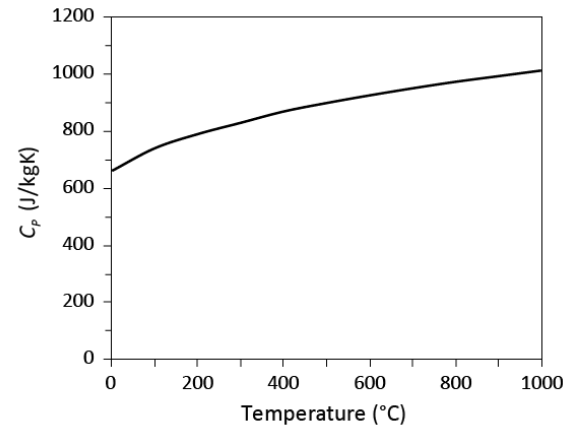
Figure 8. Specific heat of the drainage layer with respect to temperature.